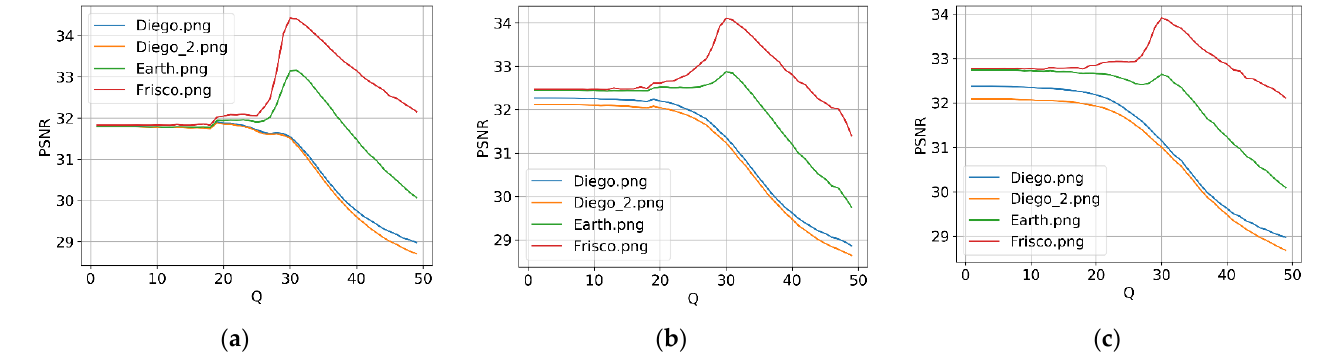
Figure 3. Dependencies PSNR tc ( Q ) for four considered three-channel images in formats 4:4:4 ( a ), 4:2:2 ( b ), and 4:2:0 ( c ).